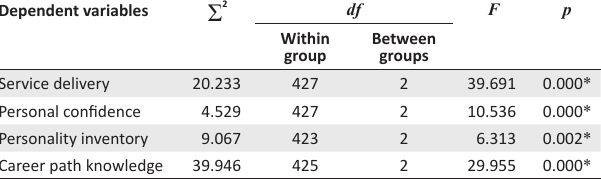
TABLE 5: Analysis of variance results for type of school as independent variable Dependent variables Σ 2